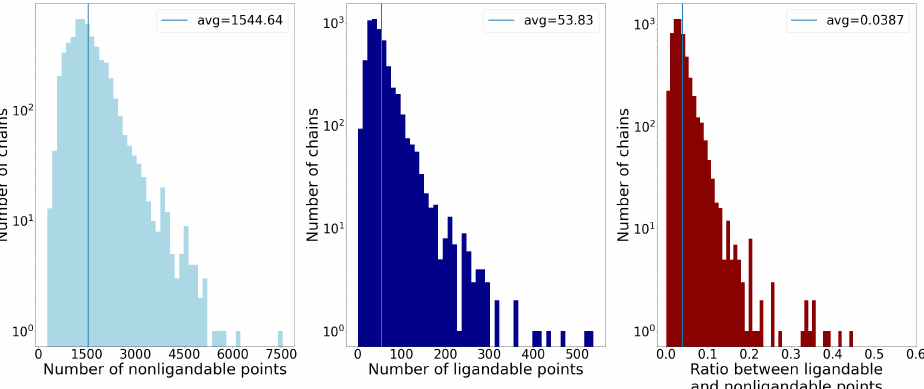
Figure 5. The first two histograms show the number of non-ligandable and ligandable points by the number of chains, and the third one shows the ratio between ligandable and non-ligandable points. The average of each property is represented by vertical lines. The main takeaway is that on average less than 4% of the points are ligandable, which presents a problem when sampling data for machine